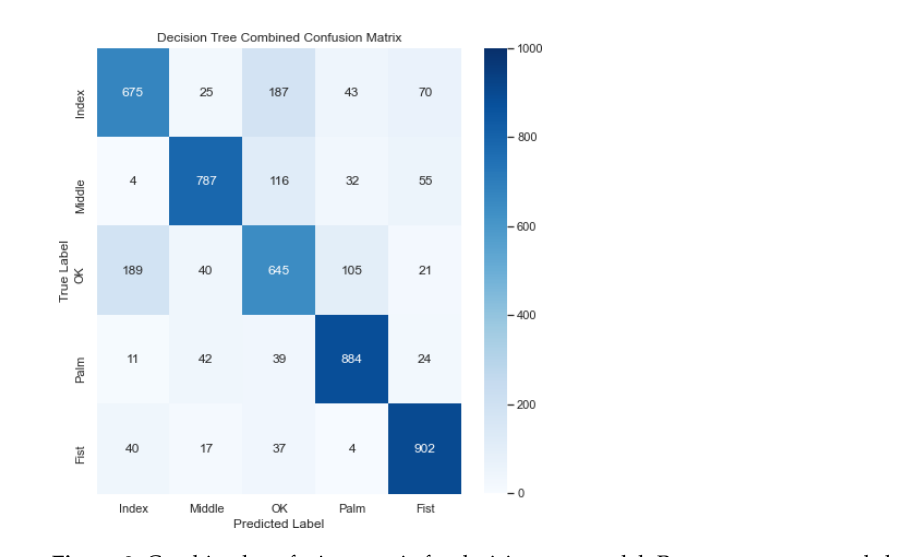
Figure 10. Combined confusion matrix for MLP model. Rows represent actual classes; columns rep- resent predicted classes. Dark blue shading indicates a large value; light blue shading indicates a small value. The average accuracy, precision, recall, and 𝐹 1 score for this model were 96.87%, 92.25%, 92.16%, and 92.16%, respectively.